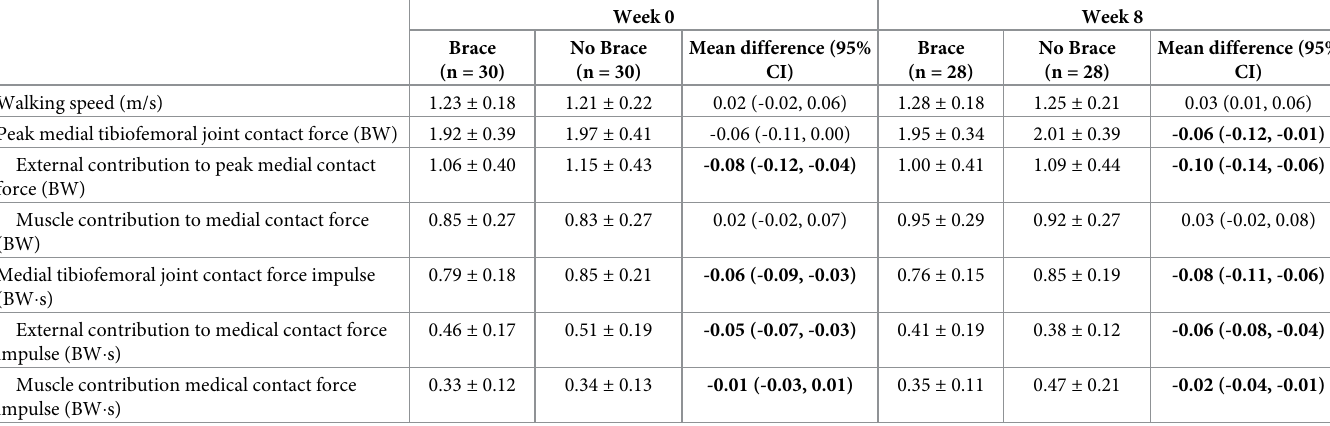
Table 3. Spatiotemporal and joint contact force related variables for brace and no brace conditions at week 0 and week